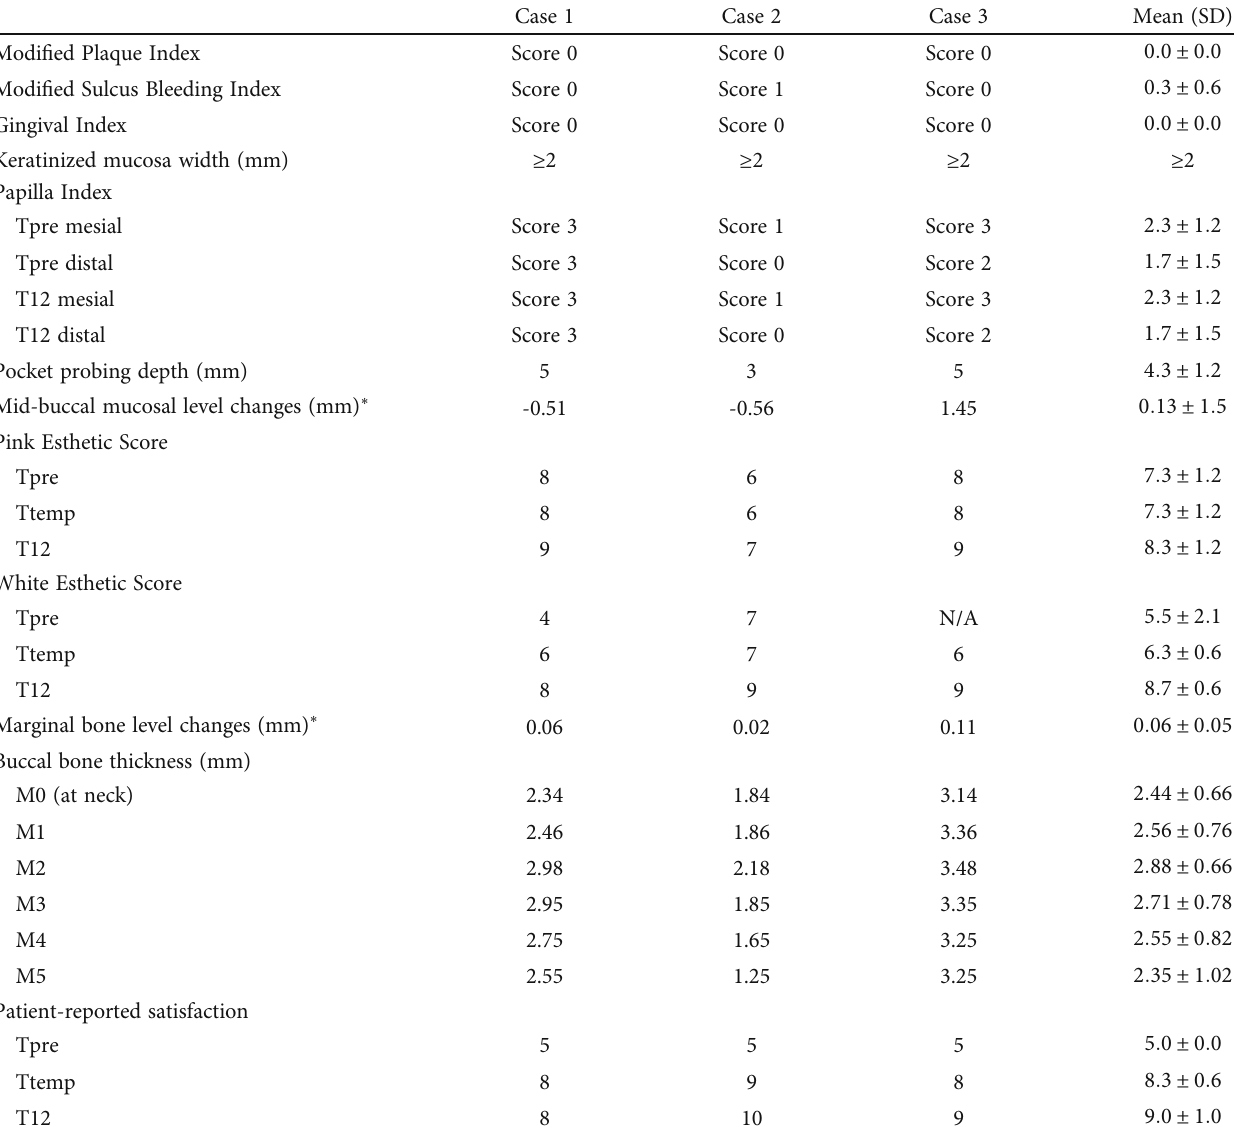
Table 3: Modi fi ed Plaque Index, modi fi ed Sulcus Bleeding Index, and Gingival Index (scores 0-3), keratinized mucosa width, Papilla Index (scores 0-4), and pocket probing depth at T12. Midbuccal mucosal level changes from Tpre to T12. Modi fi ed Pink Esthetic Score and White Esthetic Score (scores 0-10). Marginal bone level changes from T1 to T12. Buccal bone thickness at T12. Patient-reported satisfaction (scores